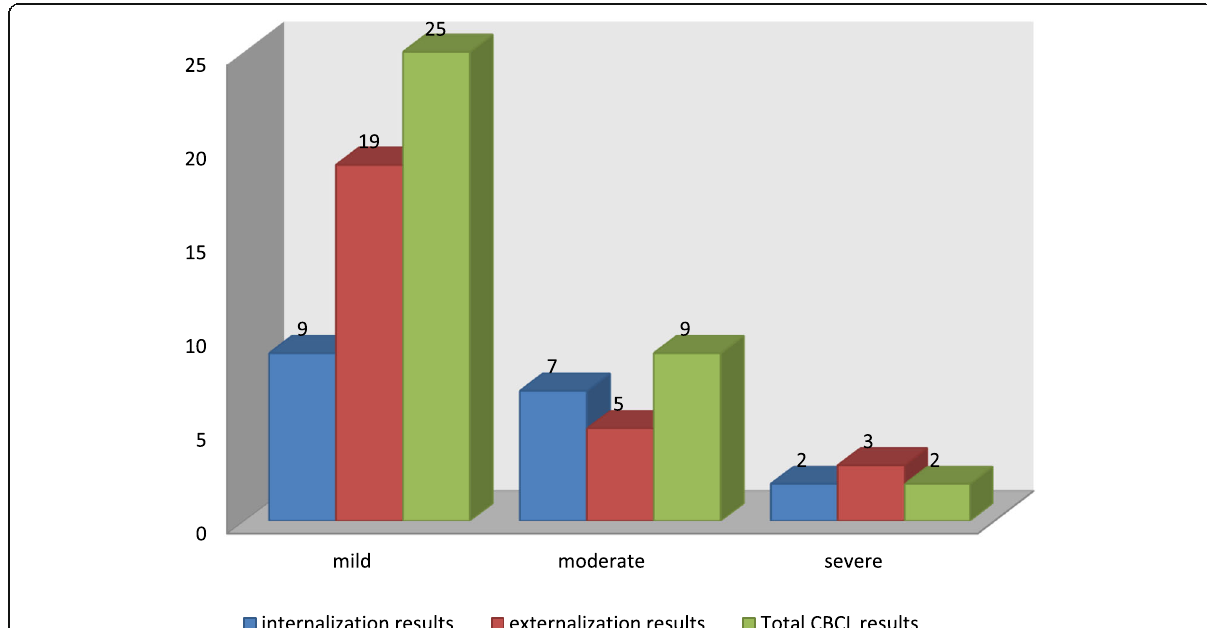
Fig. 2 Child Behavior Checklist results as regards the no. and % show no significant difference between the three groups A, B, and C (mild,